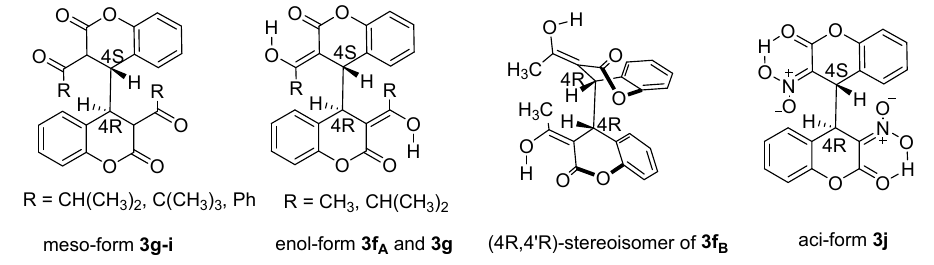
Figure 2. Stereoisomers of tetrahydrobiscoumarins 3g – j .